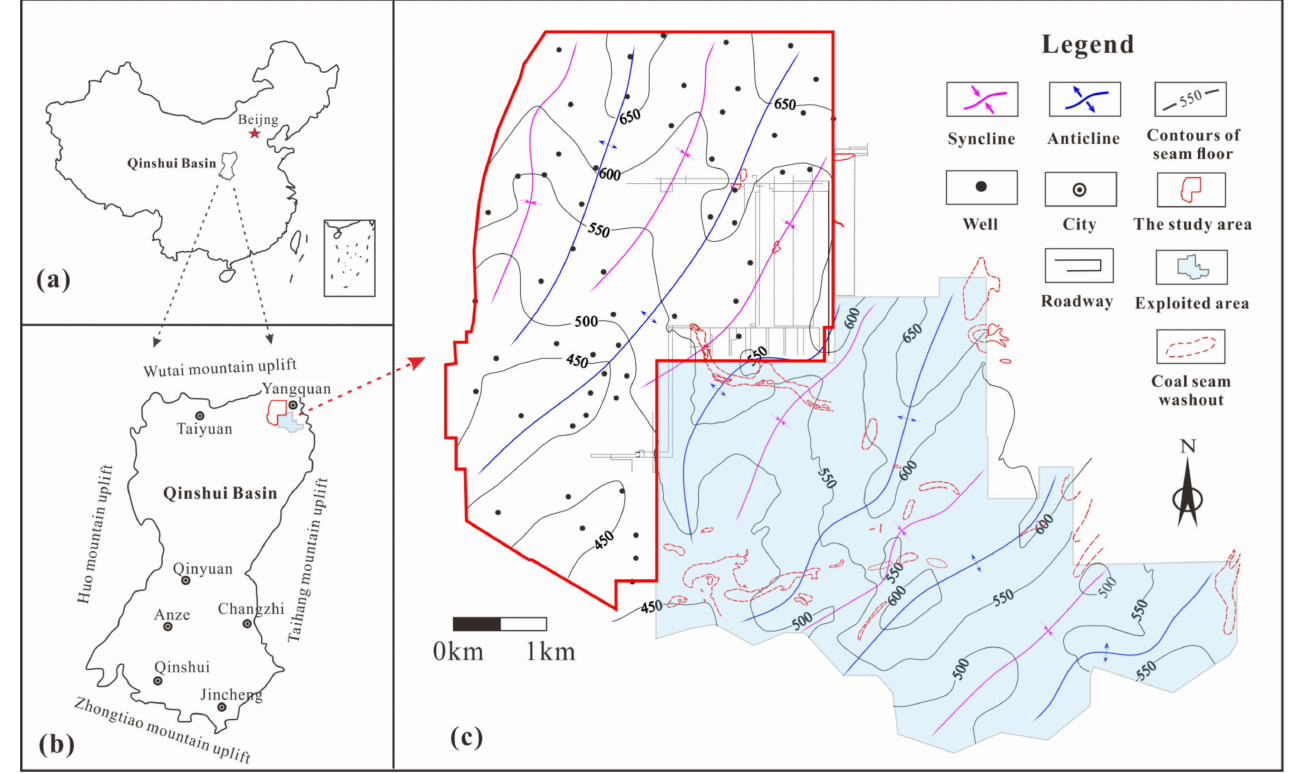
Figure 1. Map of the research area showing the geological structures and wells. ( a ) Location map of the Qinshui Basin. ( b ) Location of the research area in Qinshui Basin. ( c ) The major structures and wells in research area. Notably, the exploited area shows that coal seam was significantly affected by